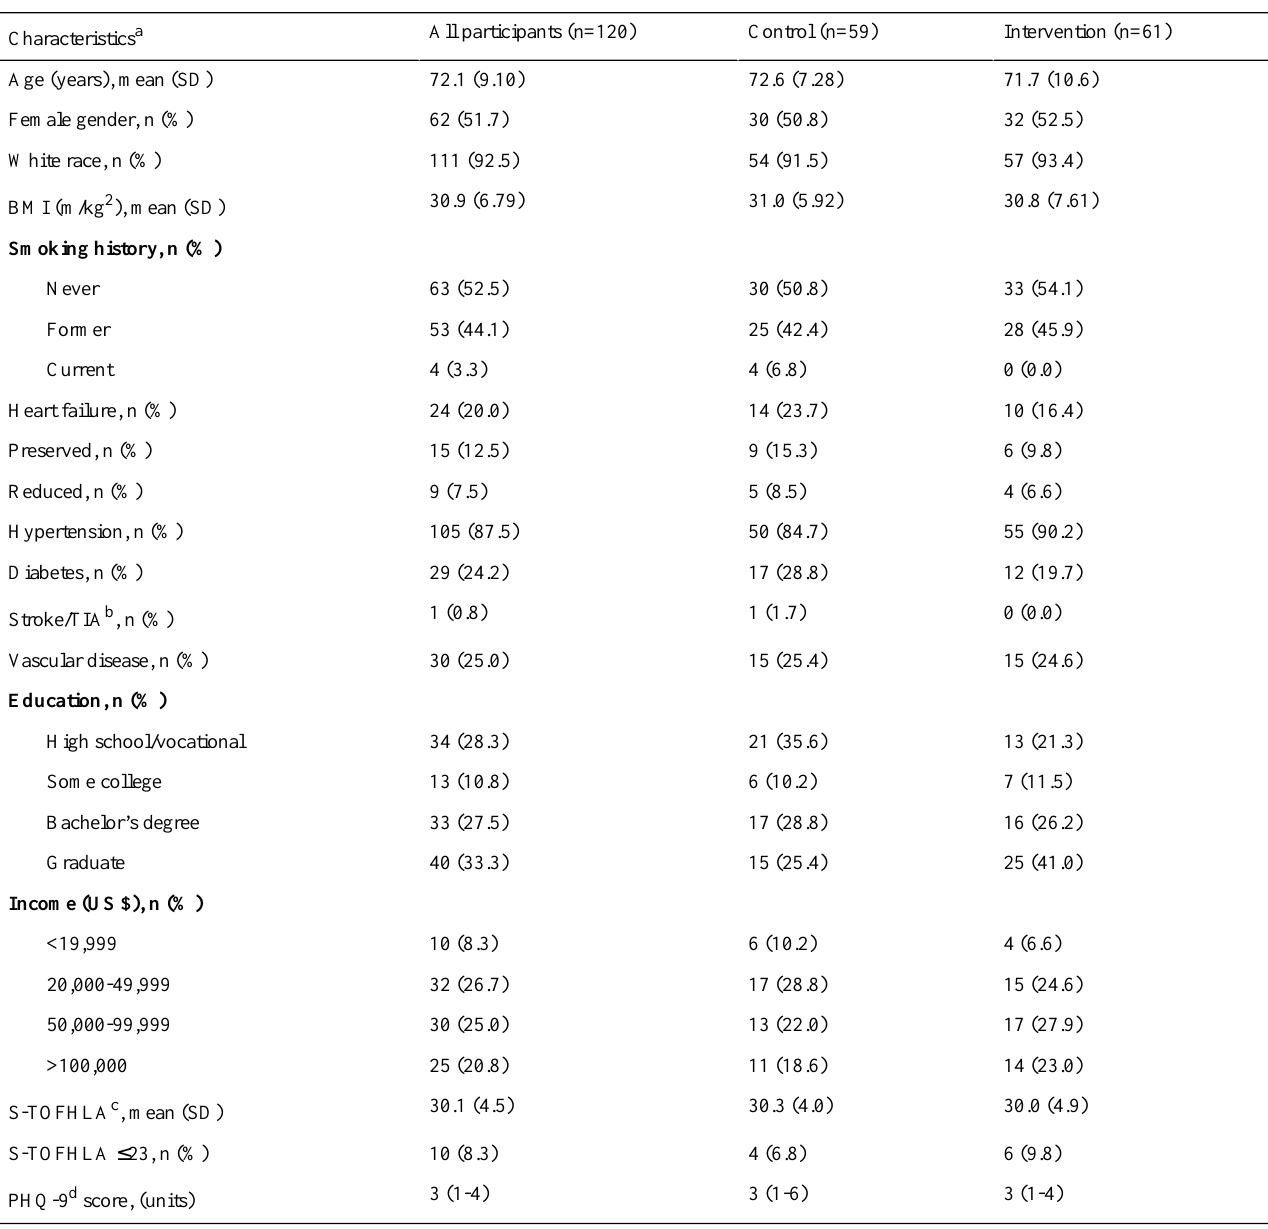
Table 1. Characteristics of pilot trial participants by treatment